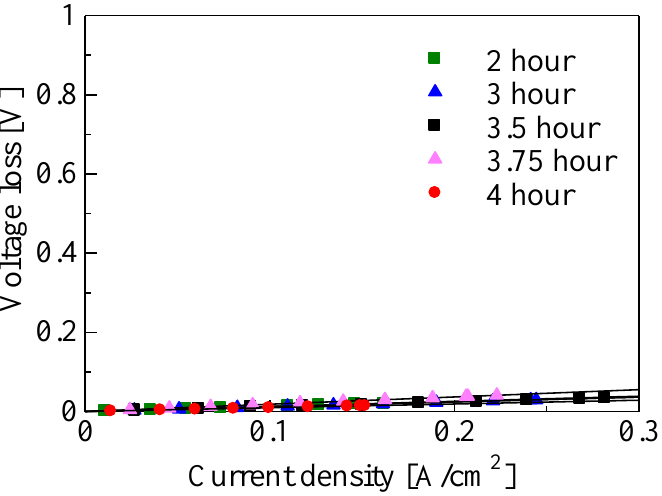
Figure 7. Resistance polarization for various growth times.